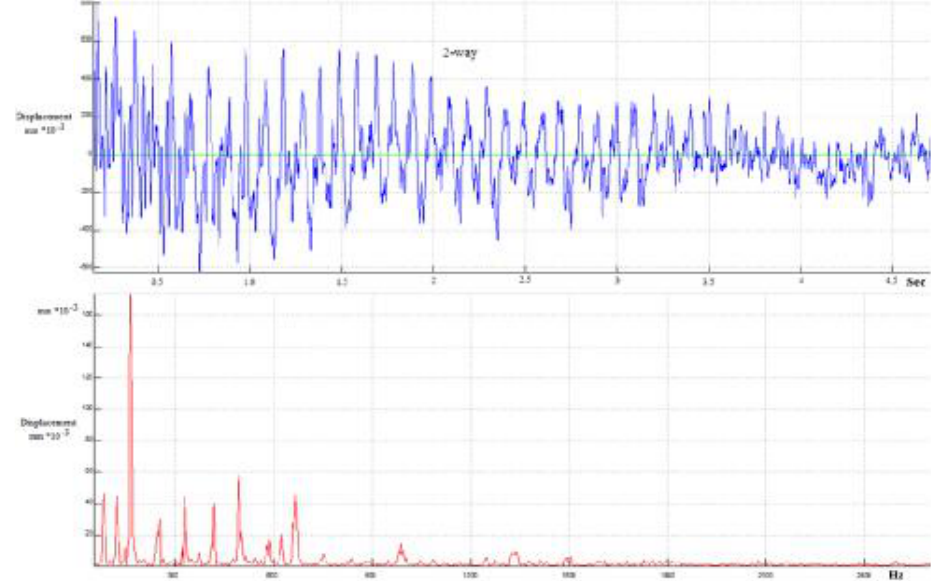
Fig. 9. Displacement of globe valve obtained from numerical solution 2-way.